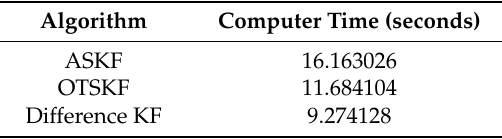
Table 1. The computer time of the three